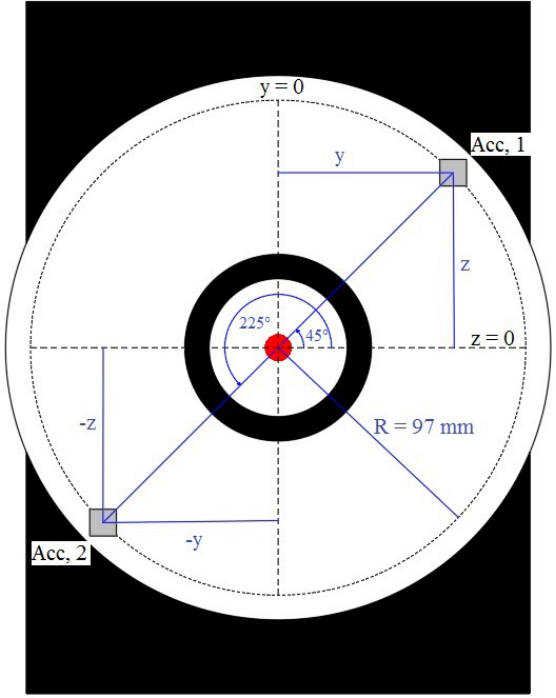
Figure 1. Installation of the accelerometers on the front mask of a